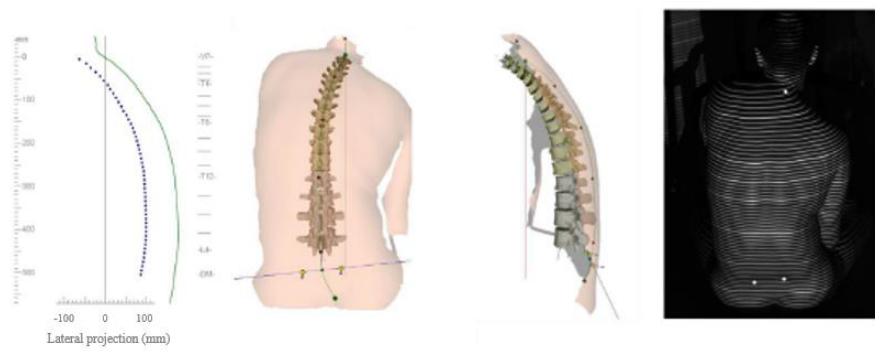
Figure 13. Sitting position on a dynamic chair without involvement of the back muscles.